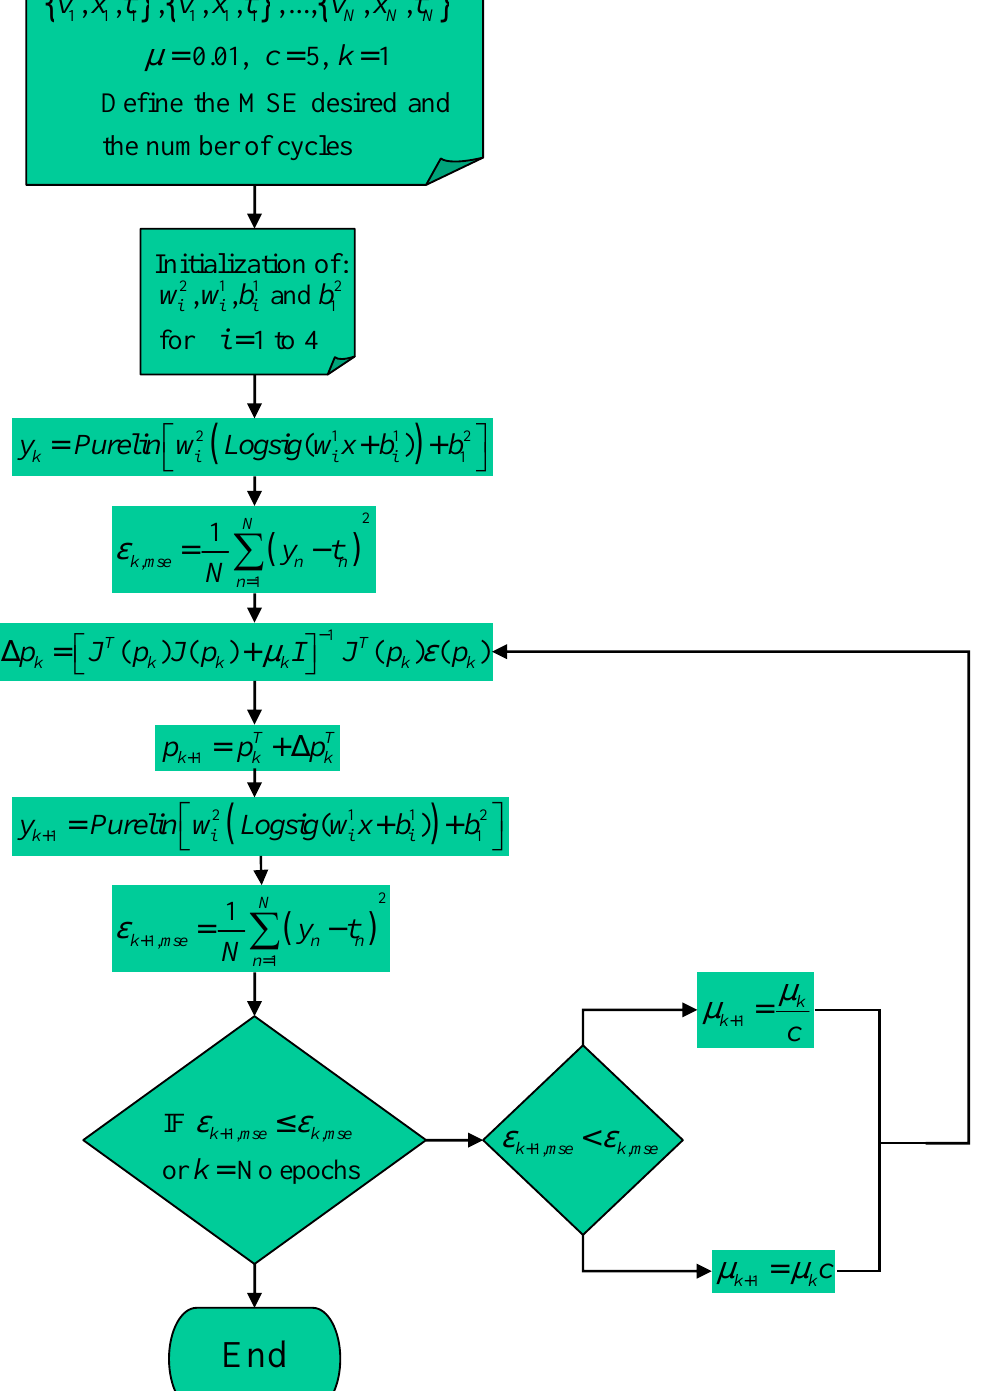
Figure 2. Flow chart of the LMBP